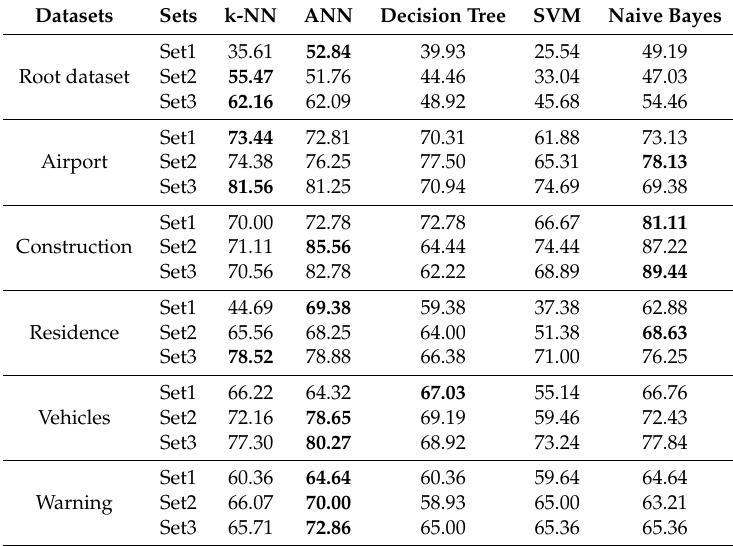
Table 8. Average accuracy in percentage per data set. The best classifier per data set is highlighted in bold.